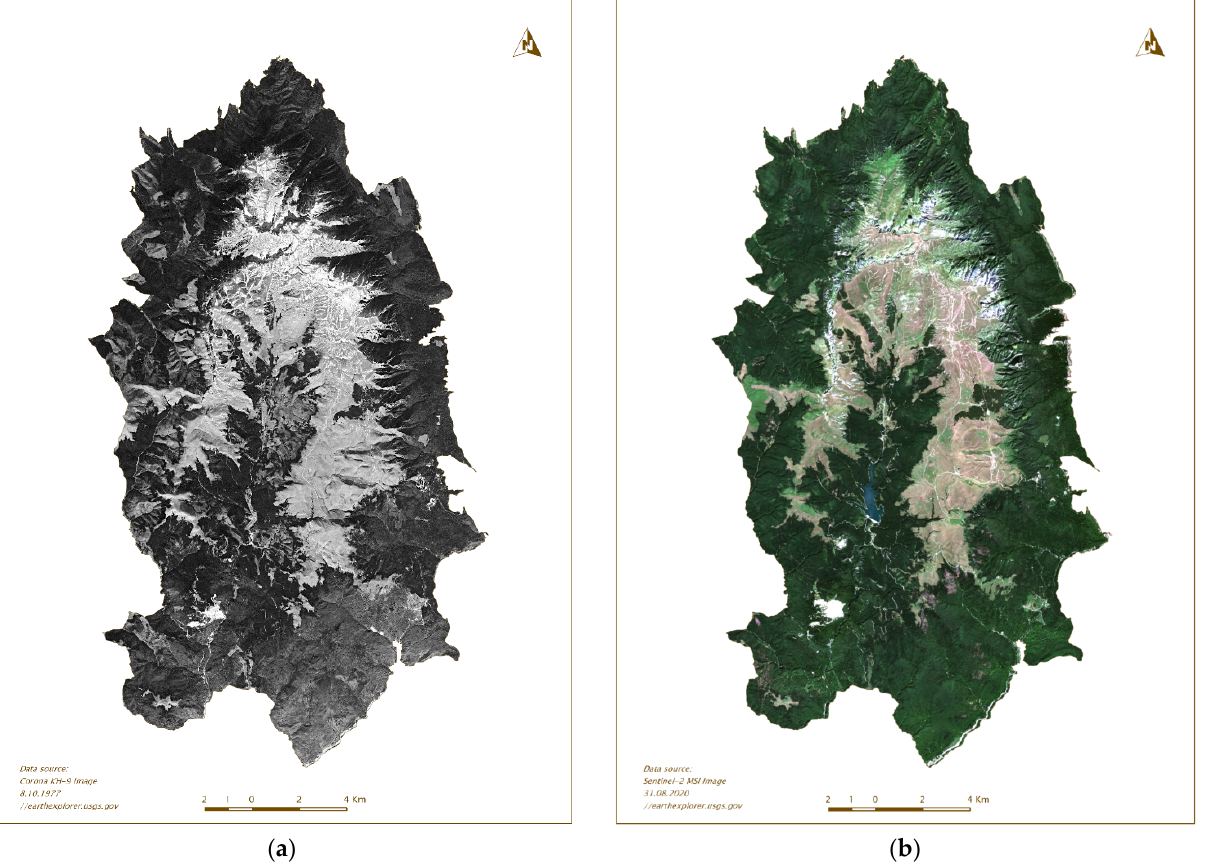
Figure 3. Bucegi Natural Park diachronic satellite imagery data coverages: ( a ) panchromatic image Corona KH-9 from 1977; ( b ) multispectral image Sentinel-2 MSI from 2020. Data sources: ( a )